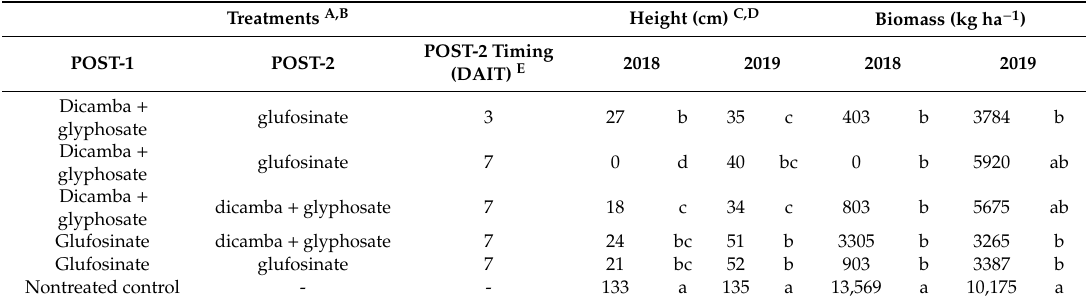
Table 5. Palmer amaranth height and biomass as a ff ected by sequential applications of dicamba and glufosinate in 2018 and 2019 field